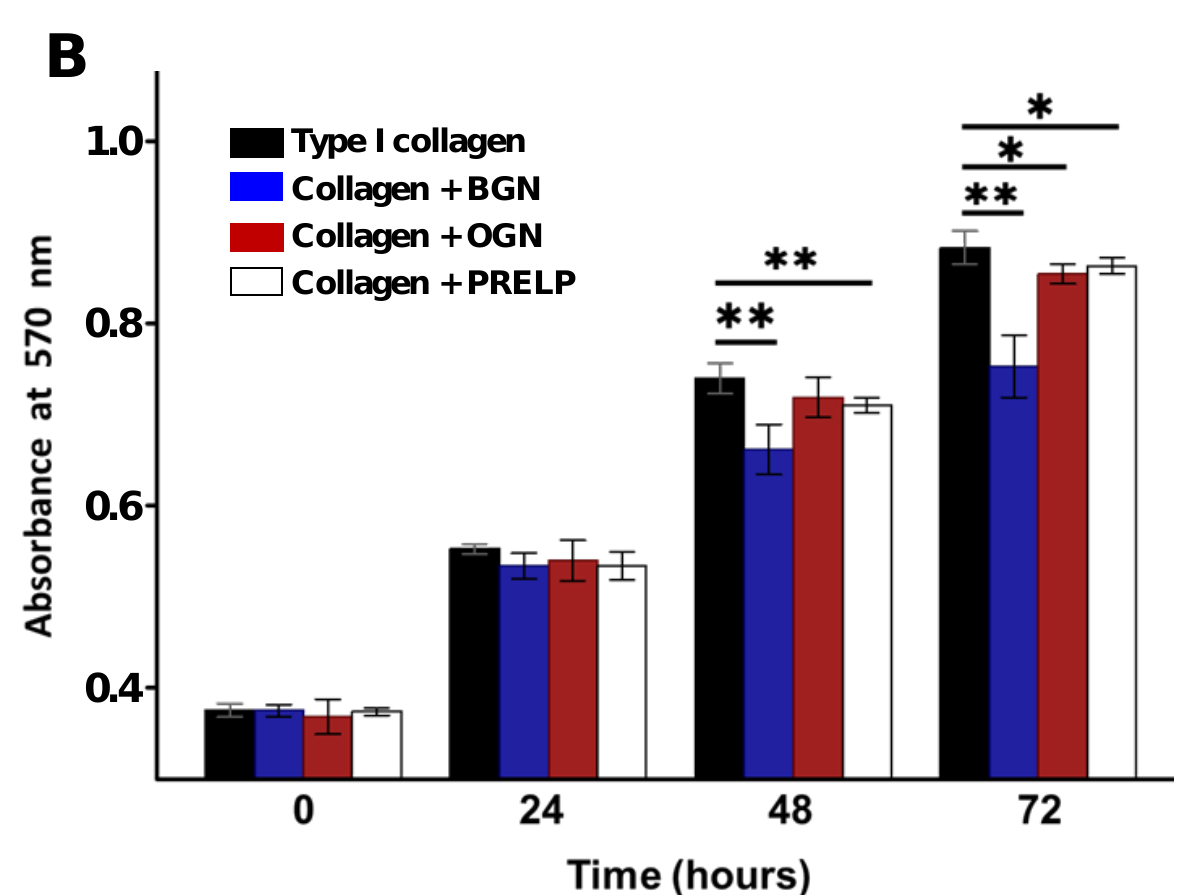
Figure 5. Influence of SLRPs on HT29 cell motility and proliferation. ( A ) In vitro scratch assay on plates coated with: ( • ) Type I collagen, ( (cid:4) ) collagen + BGN, ( (cid:78) ) collagen + OGN, ( (cid:7) ) collagen + PRELP. ( B ) Cell Proliferation Assay on plates coated with: Type I collagen (black bars), collagen + BGN (blue bars), collagen + OGN (red bars), collagen + PRELP (white bars). Spreads represent standard deviation. Values that display significant differences are highlighted: *: p < 0.05, **: p <